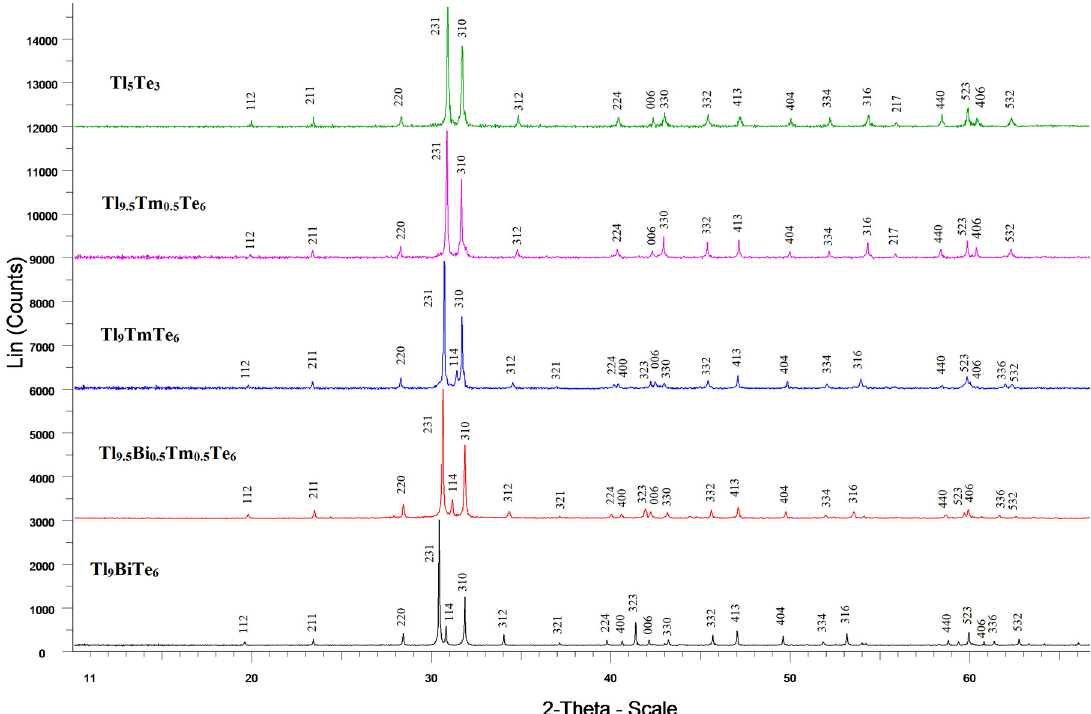
Te -Tl TmTe 5 3 9